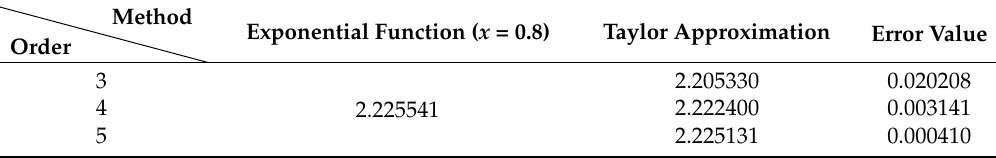
Table 1. The error value of exponential function and Taylor approximation.